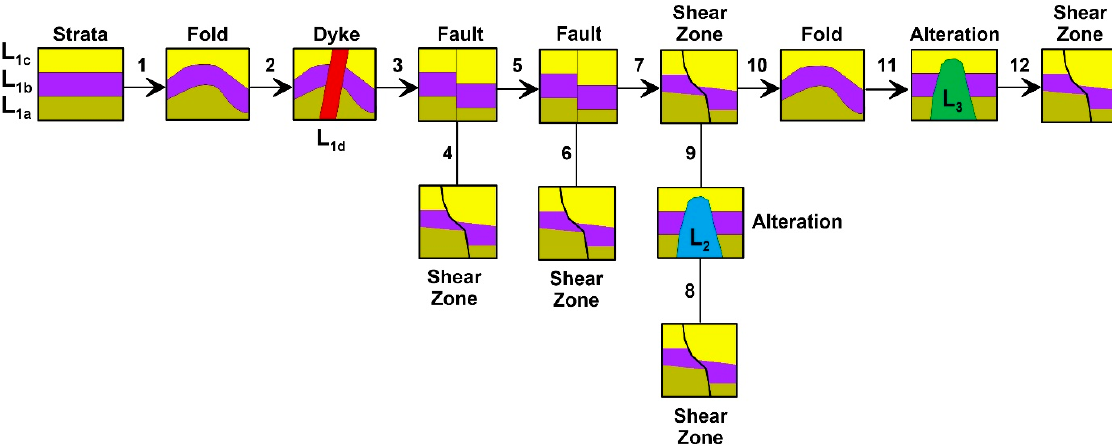
Figure 2. Workflow of geological model construction. The background geology consisted of a three-layer stratum ( L 1 a , L 1 b , L 1 c ) intruded by a dyke ( L 1 d ). After several faulting and shear deformation, two alteration events ( L 2 and L 3 ) and further deformations overprinted the host geology. Noddy 3D geological and geophysical modeling package was used to build the geological model [43].